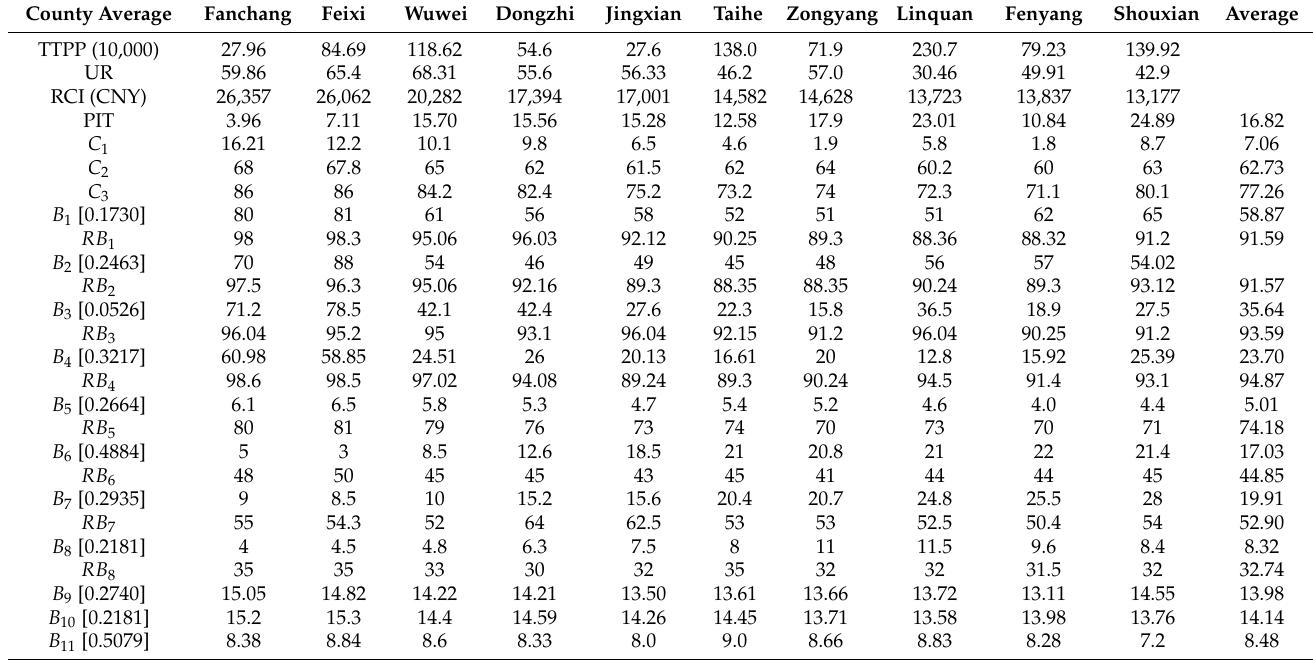
Table 3. Economic development and water pollution control of 10 sample counties in 2020 Relative units: